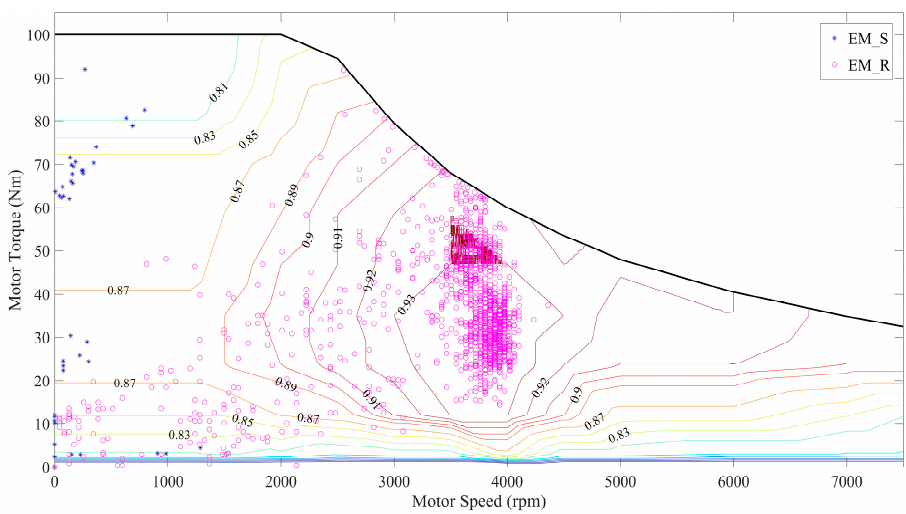
Figure 12. Working points of the motors at PDR = 0.5.